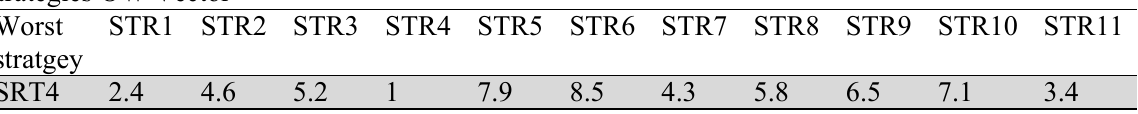
Strategies OW Vector Worst